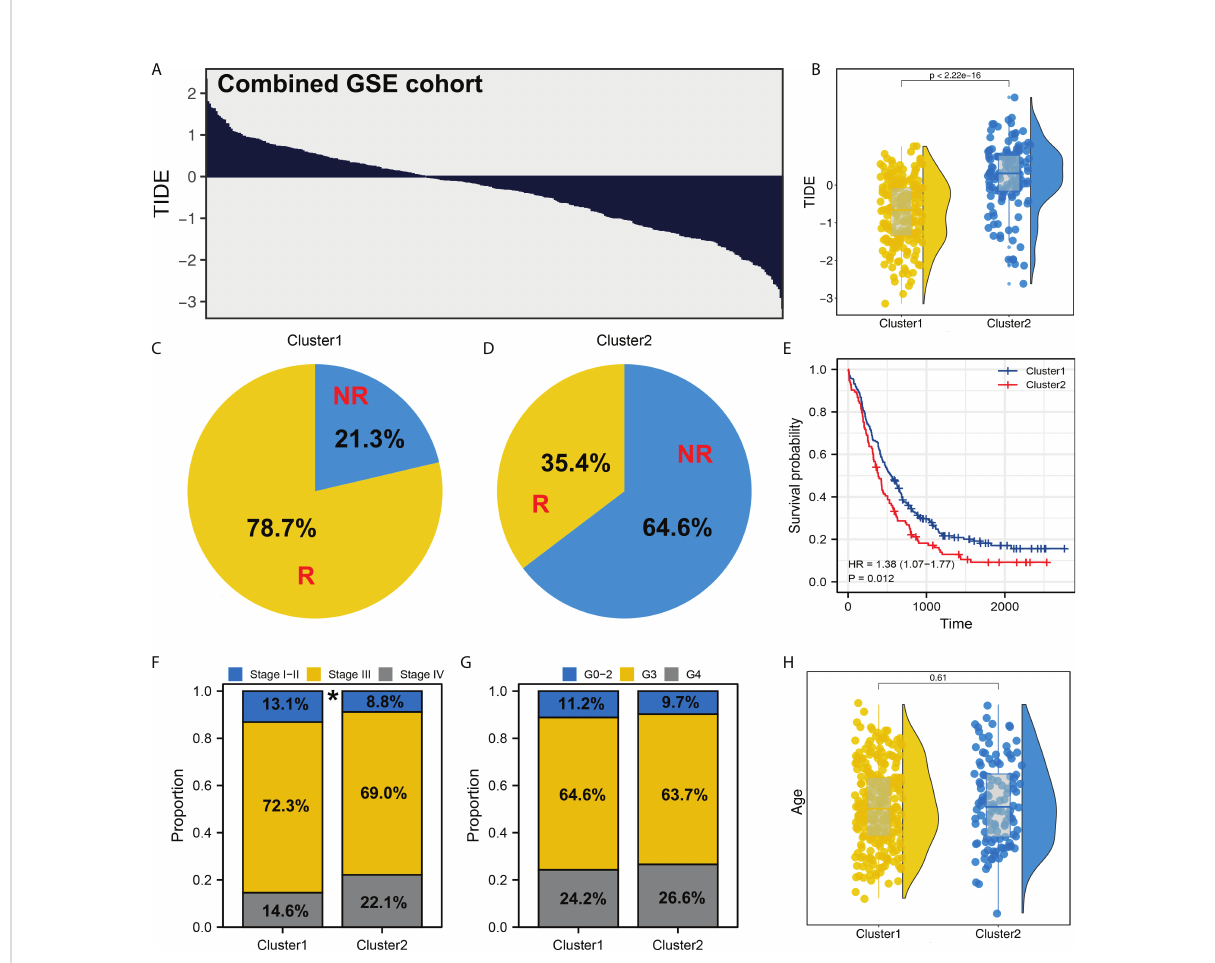
FIGURE 4 Validation in GSE cohort. (A) TIDE analysis was performed in the combined GSE cohort; (B) In the GEO cohort, Cluster2 also had a higher TIDE score; (C, D) The proportion of immunotherapy responders and non-responders in Cluster1 and Cluster2 patients; (E) KM survival curve of Cluster1 and Cluster2 patients; (F – H) Clinical differences between Cluster1 and Cluster2 (gender, age and grade). * = P <